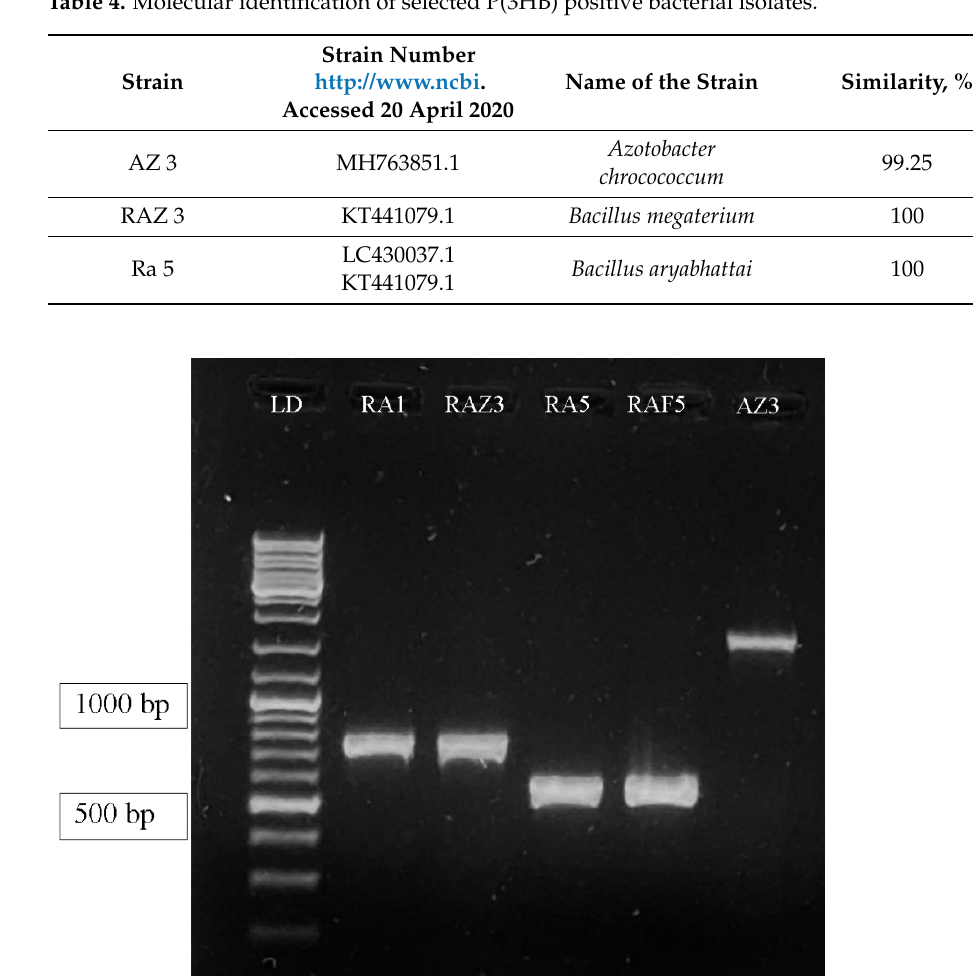
Figure 4. Gel showing polymerase chain reaction (PCR) amplification by primer pairs (BmRv and BmFw; BaRv and BaFw; AzRv and AzFw) specific to the phb gene. Track 1: DNA ladder, track 1–2